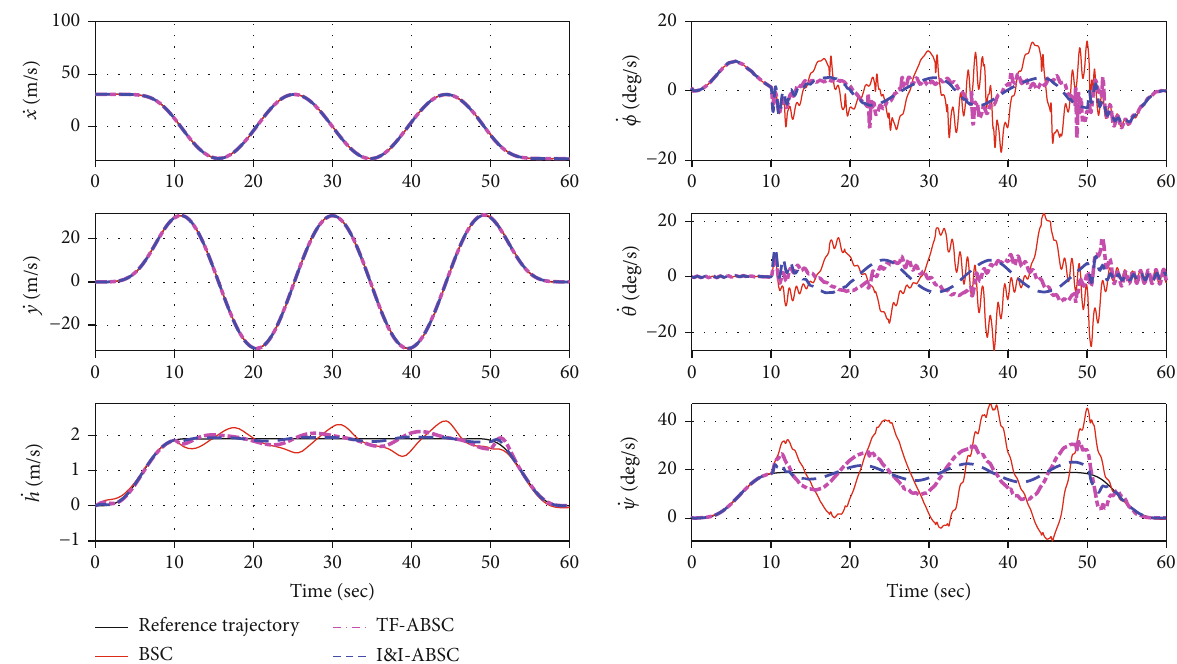
Figure 11: Case B: velocity tracking results of BSC, TF-ABSC, and I&I-ABSC.